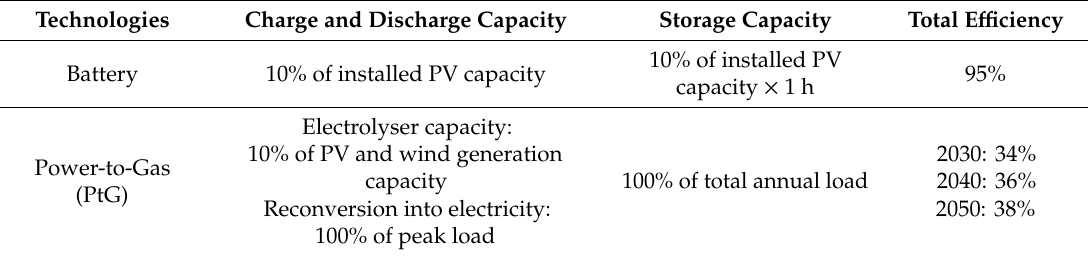
Table A3. Characteristics of storage technologies. Source: References [45,46] and own